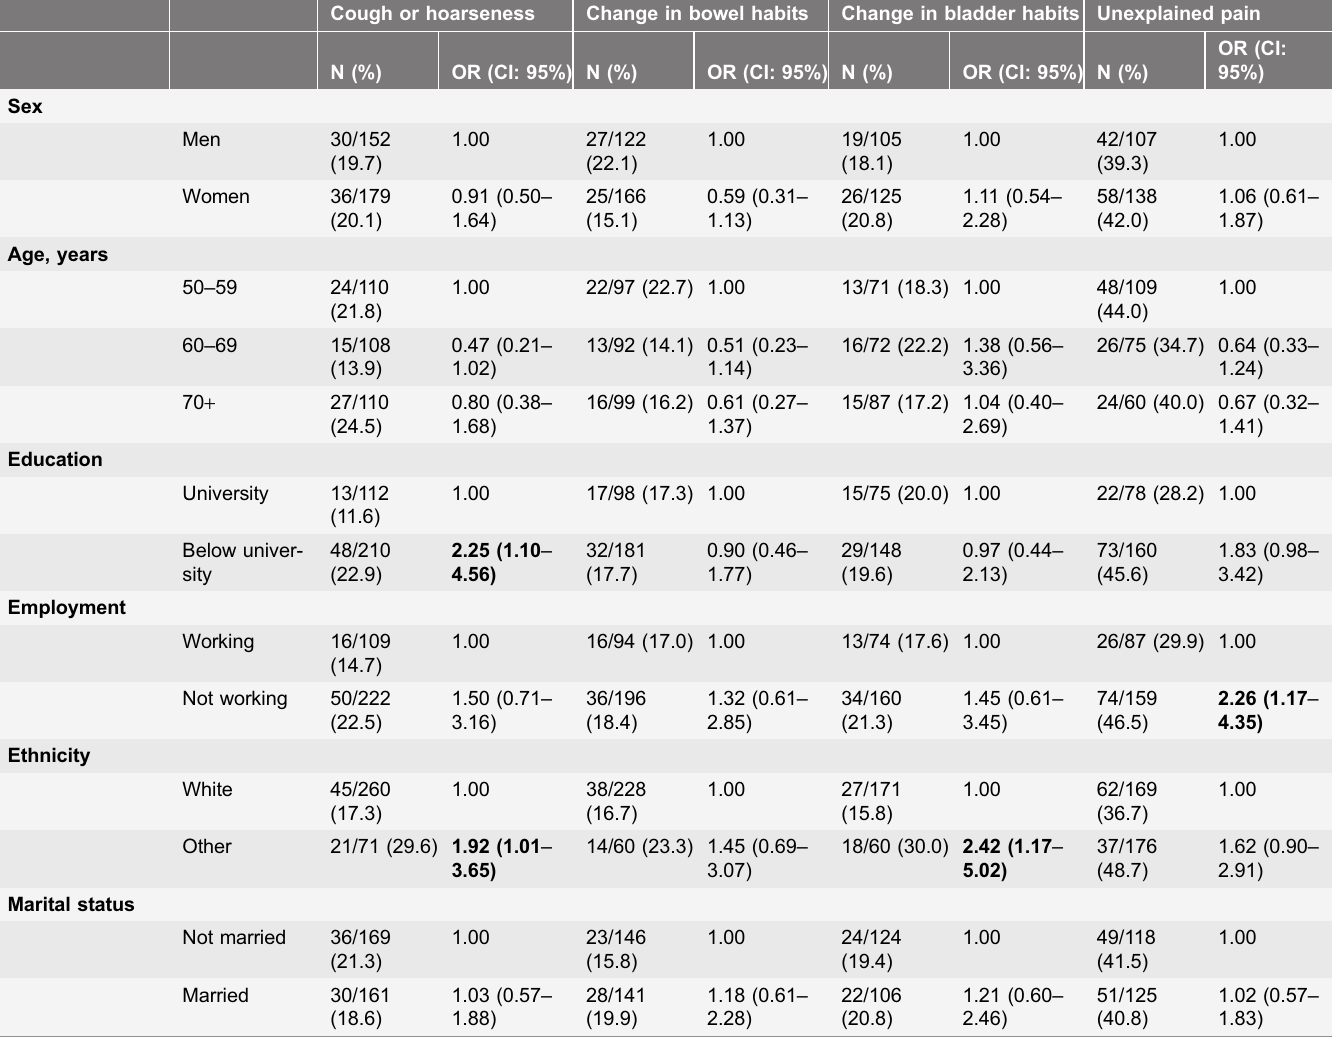
Table 3. Prevalence and adjusted odds ratios of reporting higher perceived seriousness for cancer ‘alarm’ symptoms in the last 3